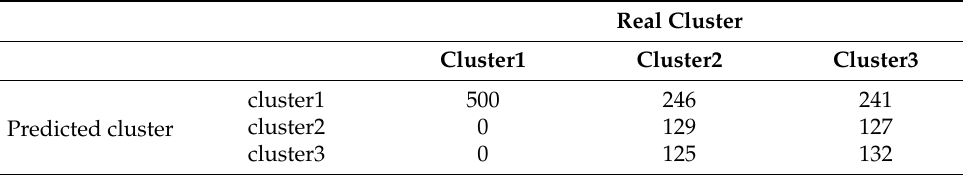
Table 2. Confusion Matrix of the simulation data based on the K-means model.